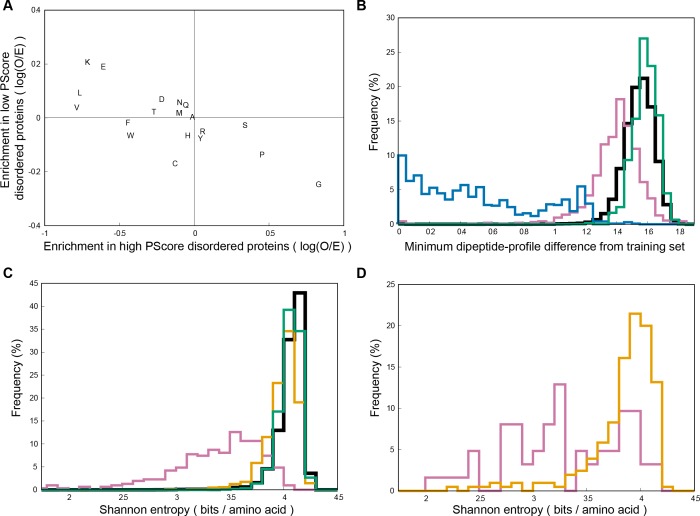
Sequence comparisons of high PScore proteins.Panel (A) shows compositional bias, relative to the human average, for the high PScore disordered proteins (x-axis) and low PScore disordered proteins (y-axis) used in panel B. High PScore disordered proteins are enriched primarily in Pro and Gly, while low PScore disordered proteins are not enriched in either, but enriched primarily in Lys and Glu, matching our observation that Arg to Lys mutations abrogate phase separation propensity. Panel (B) shows similarity to the training set measured by minimum dipeptide profile distance to any training set protein, as described in the methods. High PScore (≥4.0) human sequences (in pink) are on average closer to the training set than are all human proteins (in black) or PDB sequences (in green), but the range overlaps with both, and is distinct from the similarity seen in blast level homologs of the training set (in blue). Panel (C) shows Shannon entropy distributions of the human proteome (in black), the PDB (in green), and of a set of human proteins proteins predicted to have long stretches of disorder (Disprot3 ≥0.8) split into those with high PScore (≥4, N = 310) (in pink) and low PScore (<1.0, N = 1044) (in orange), showing that PScore but not disorder results in a bias towards lower sequence entropy, suggesting a compositional bias in phase-separating sequences. Panel (D) shows Shannon entropy values for our natural-protein phase separation test set (N = 62) in pink and the disorder-containing human proteins found in Disprot (N = 205) in orange, confirming the observation in panel C that lower Shannon entropy sequences are associated with phase separation.